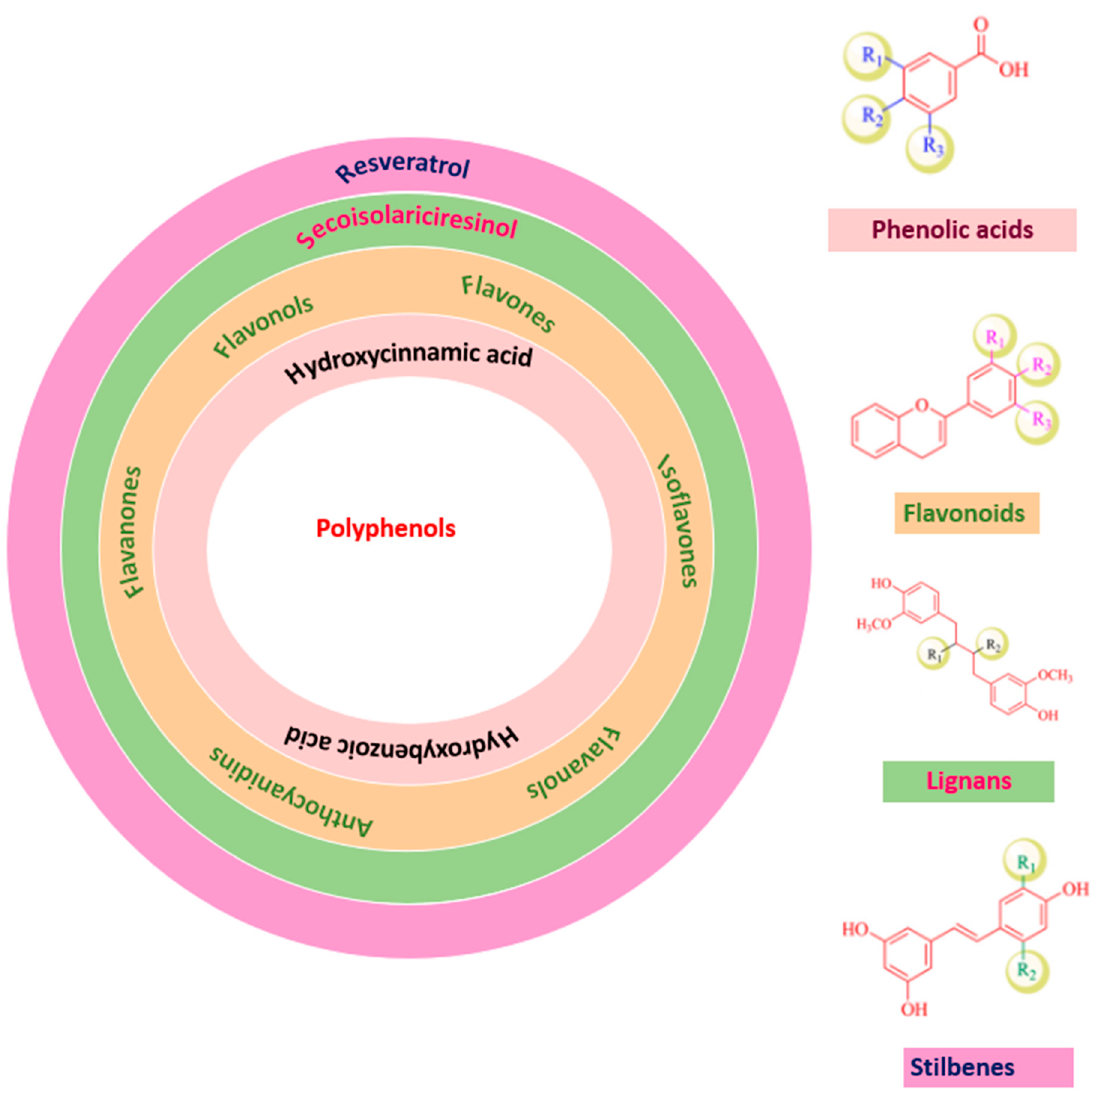
Figure 2. Polyphenols